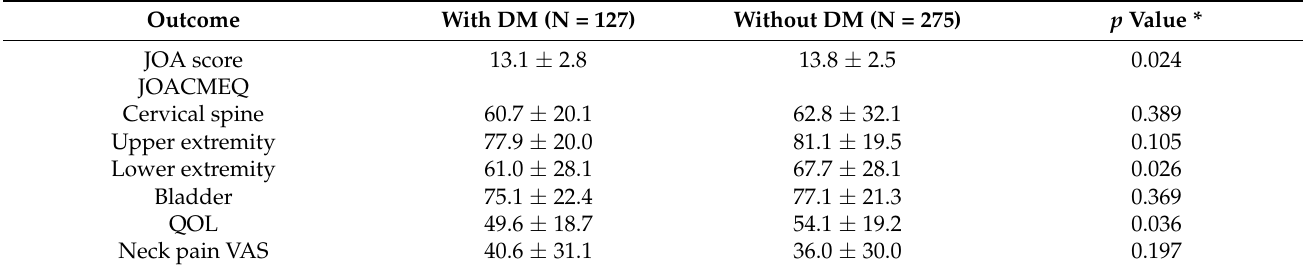
Table 3. Comparisons of functional outcomes between patients with and without diabetes mellitus at the 2-year